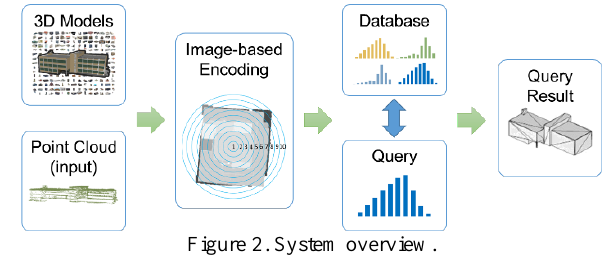
Figure 2. System overview.